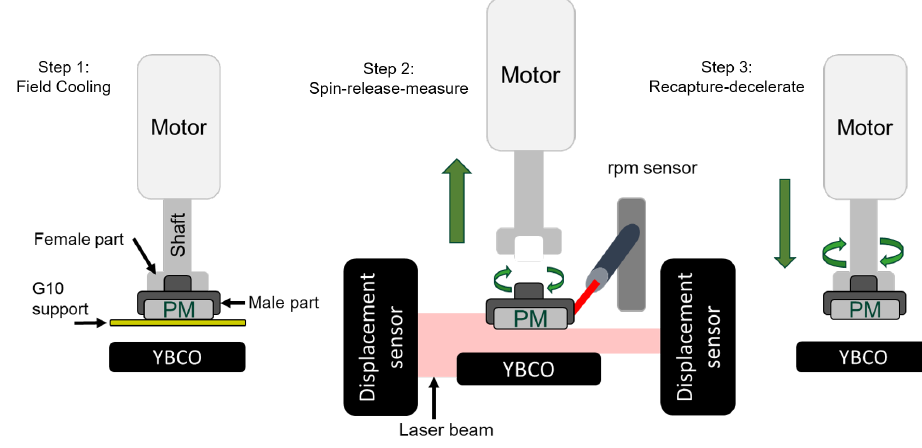
Figure 3. Spin-down experiment